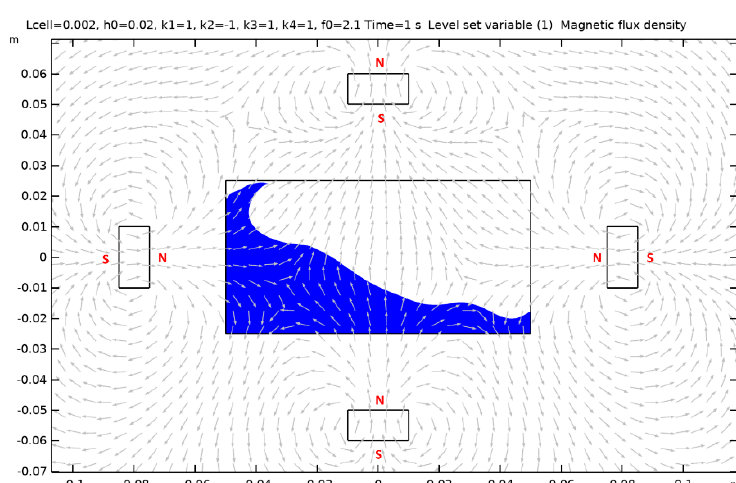
Figure A10. Case 11.